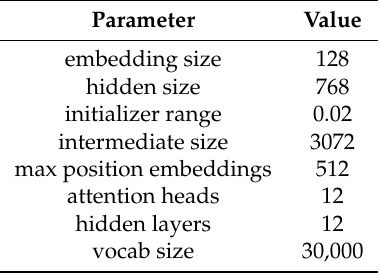
Table 1. Parameters of the Albert Base